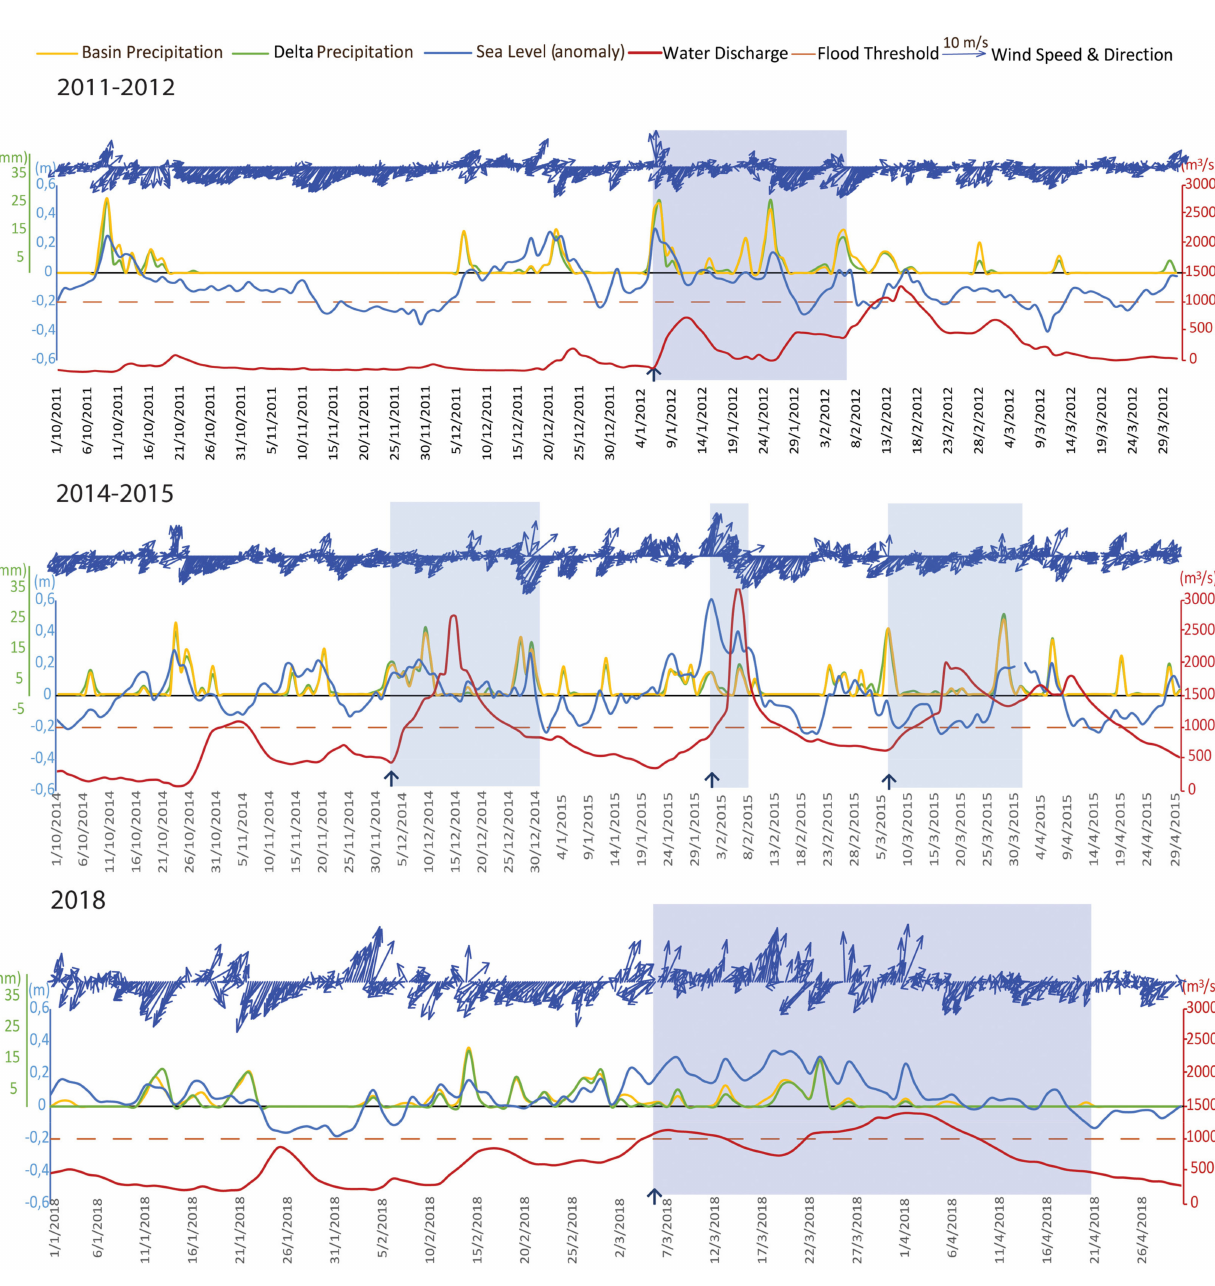
Figure 4. Temporal evolution of the sea-level anomalies, the daily basin and delta precipitation, the wind vector, and the river discharge for the examined period 2005–2018. The shaded areas indicate the periods characterized by delta flooding according to the civil protection records (see Table 1). The black arrows indicate the onset day of each